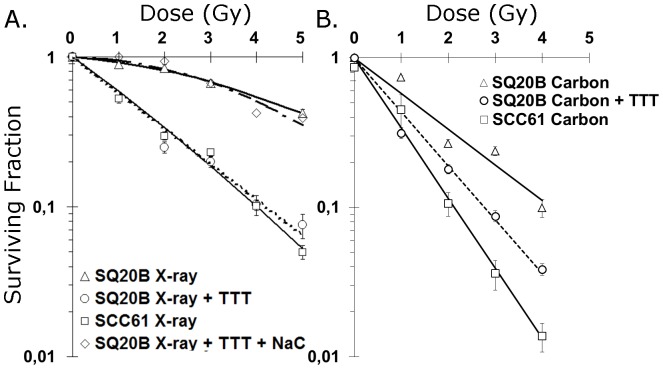
Clonogenic cell survival assay.SQ20B, DMF/BSO (TTT)-treated SQ20B, and SCC61 cells were exposed to X-ray radiation (A) or carbon ion radiation (B). The reverse effect of NaC over the glutathione depletion treatment was evaluated by coincubating DMF/BSO (TTT)-treated SQ20B with 5 mM of N-acetyl cysteine (NaC) (SQ20B+TTT+NaC) before X-ray radiation exposure.